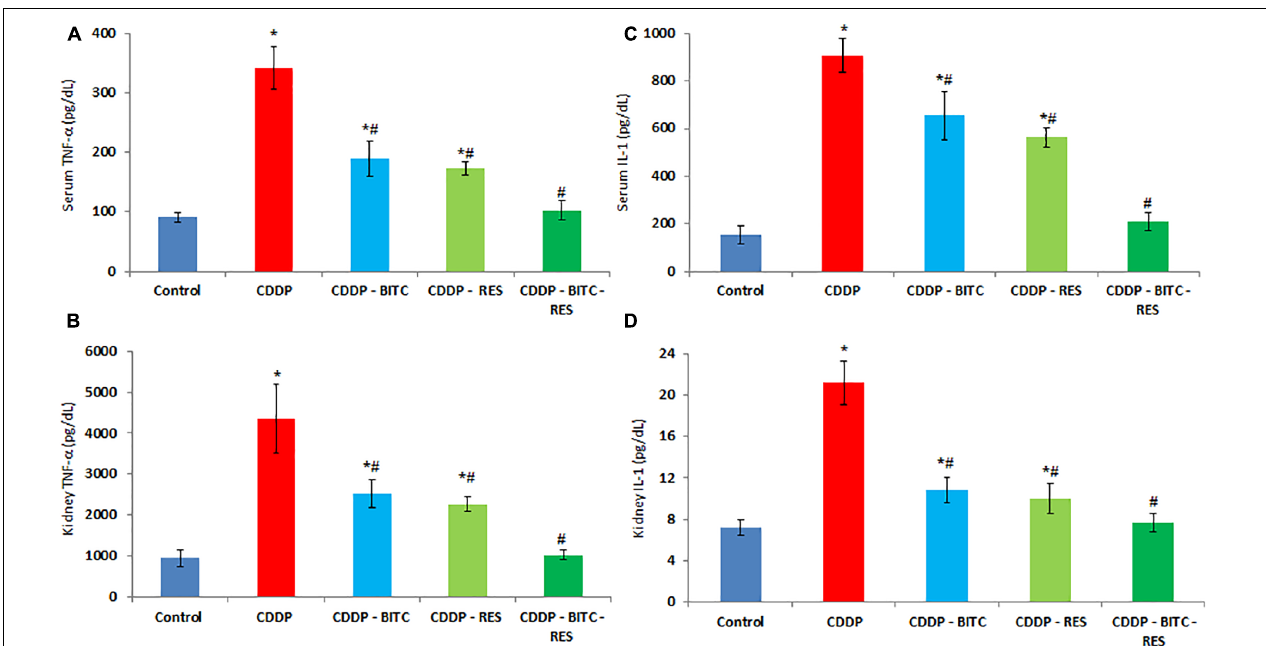
FIGURE 4 | The effects of RES and BITC treatment on serum and renal tissue levels of (A,B) tumor necrosis factor- α (C,D) interleukin-1 β in cisplatin-intoxicated mice. Data are means ± standard deviations. CDDP, cisplatin. ∗ Significantly different from the normal control group at p < 0.05. # Significantly different from the CDDP group at p < 0.05. Additionally, note that serum IL-1 β concentration in CDDP–RES group is significantly lower than in the CDDP–BITC group ( p < 0.05).